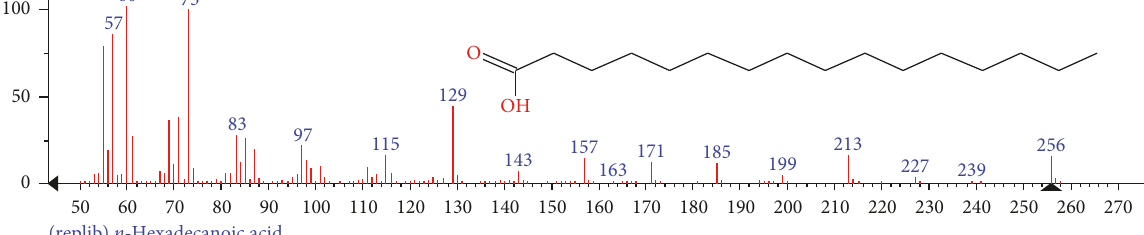
Figure 34: Mass spectrum of compound n -hexadecanoic acid of whole plant hexane fraction of Achillea wilhelmsii